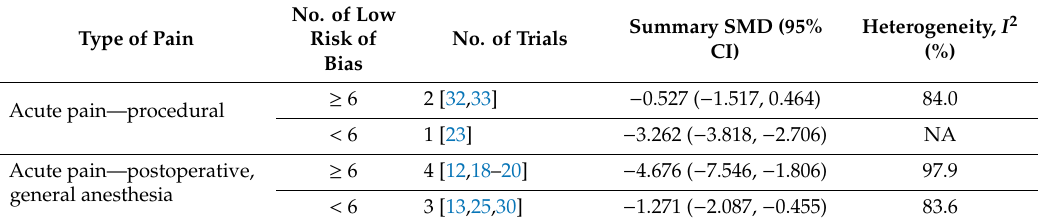
Table 4. Use of melatonin and analgesic consumption change in the subgroup meta-analysis of randomized, double-blind, placebo-controlled